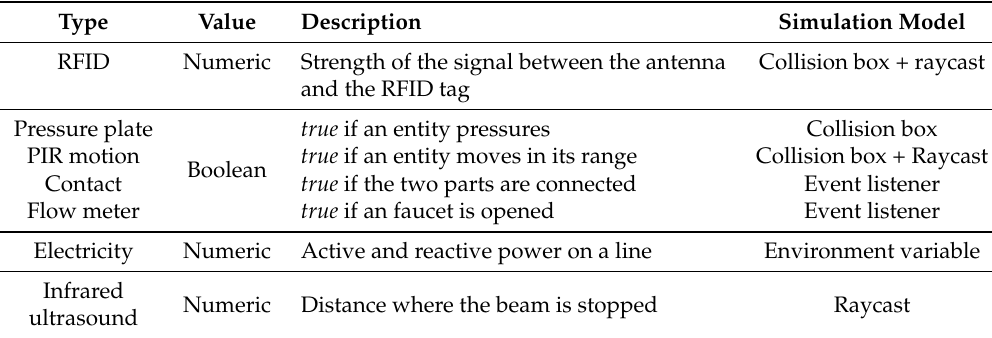
Table 2. List of sensors provided by our simulator. PIR: passive